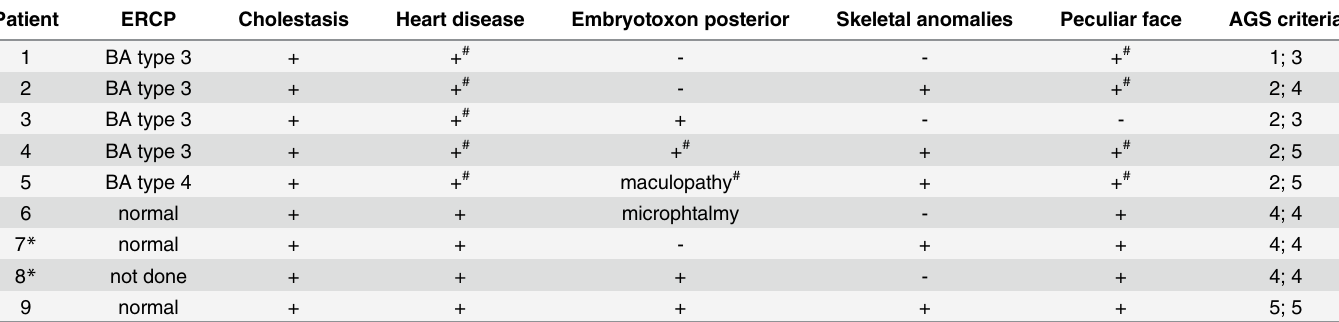
Table 2. Clinical features present in carriers of JAG1 mutations at the time of hospitalization for neonatal cholestasis and at 3 years of age.